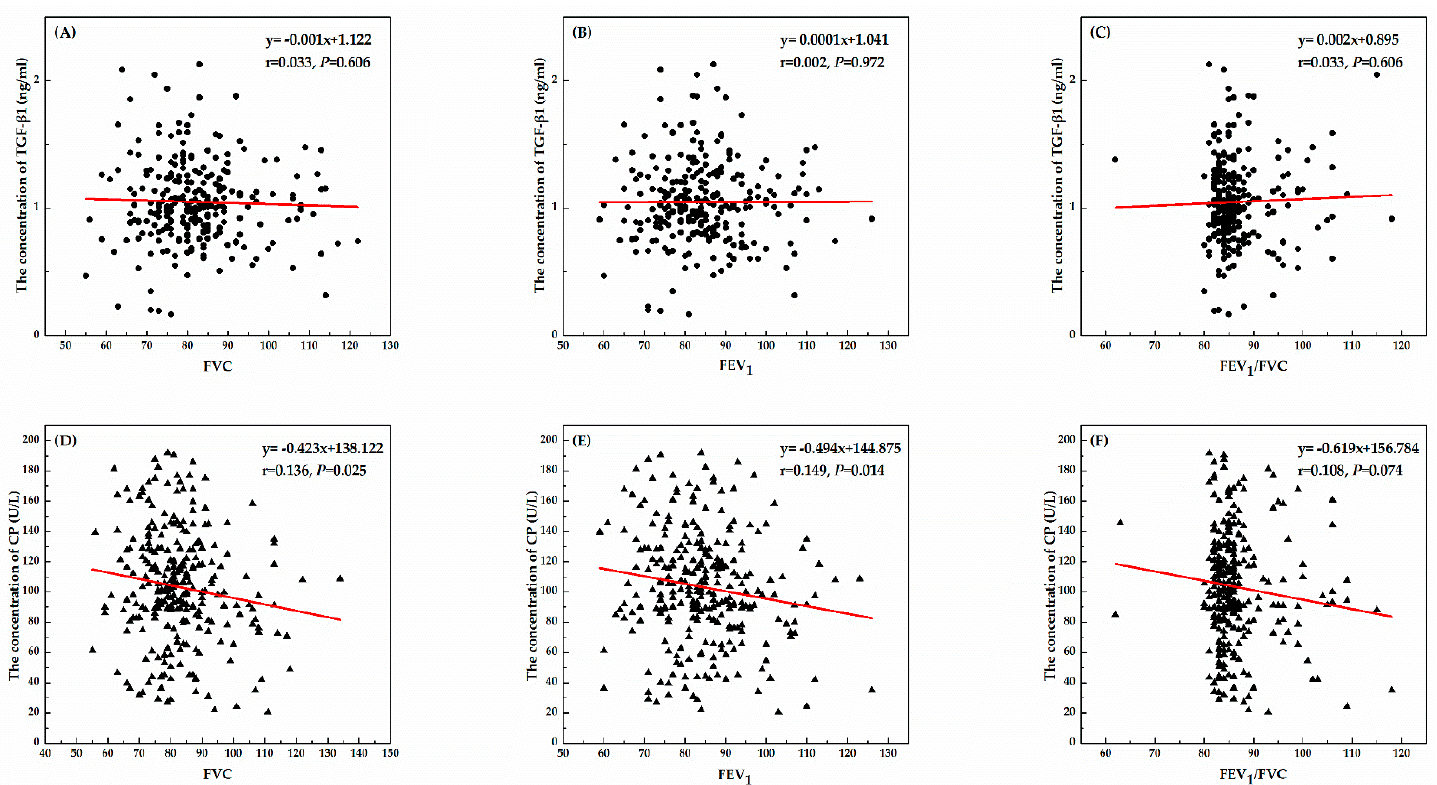
Figure 1. The correlations between TGF ‐β 1 or CP and indicators of lung function (FVC, FEV 1 , and FEV 1 /FVC) among all subjects. ( A ) The correlation between TGF ‐β 1 and FVC; ( B ) The correlation between TGF ‐β 1 and FEV 1 ; ( C ) The correlation between TGF ‐β 1 and FEV 1 /FVC; ( D ) The correlation between CP and FVC; ( E ) The correlation between CP and FEV 1 ; ( F ) The correlation between CP and FEV 1 /FVC.